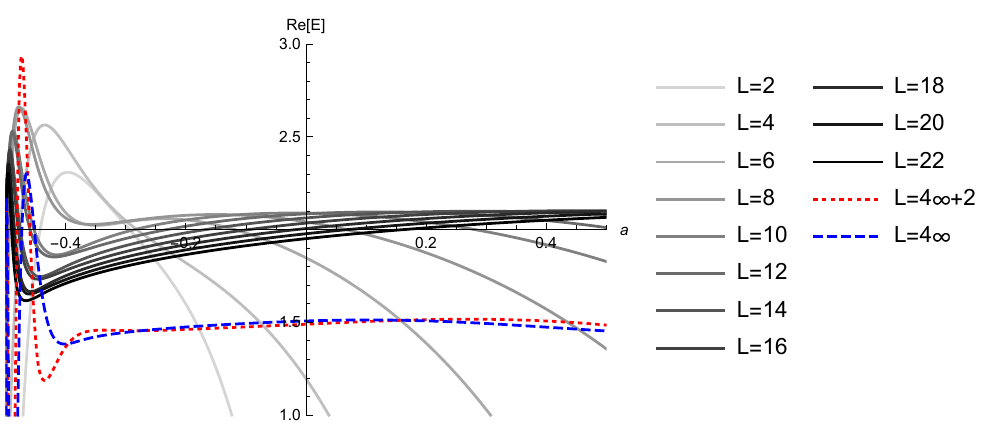
Figure 1 . Plots of the real part of the energy E (2.15) for the “double brane” solution Φ D the truncation level L . The dotted and dashed lines are extrapolations to L = 4 k + 2 ( k → ∞ ) and L = 4 k ( k → ∞ ), respectively. The horizontal axis denotes the value of the parameter a at Re E = 2 .